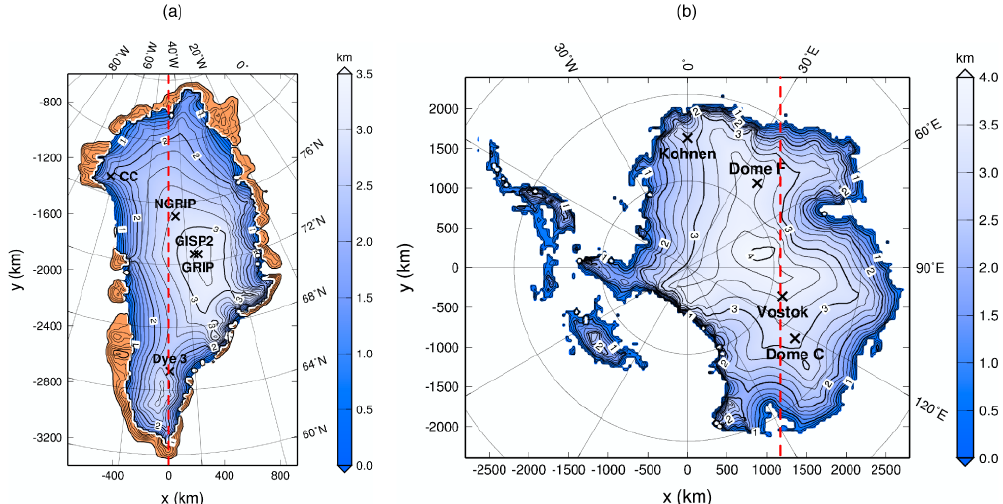
Figure 14. Simulated present-day surface topography with 200m contours of elevation in kma.s.l. Major ice core locations are marked with crosses and the location of the cross sections are marked with a red dashed line. (a) Greenland and (b) Antarctica, without the ice shelves because SICOPOLIS 2.9 does not include ice shelf dynamics.